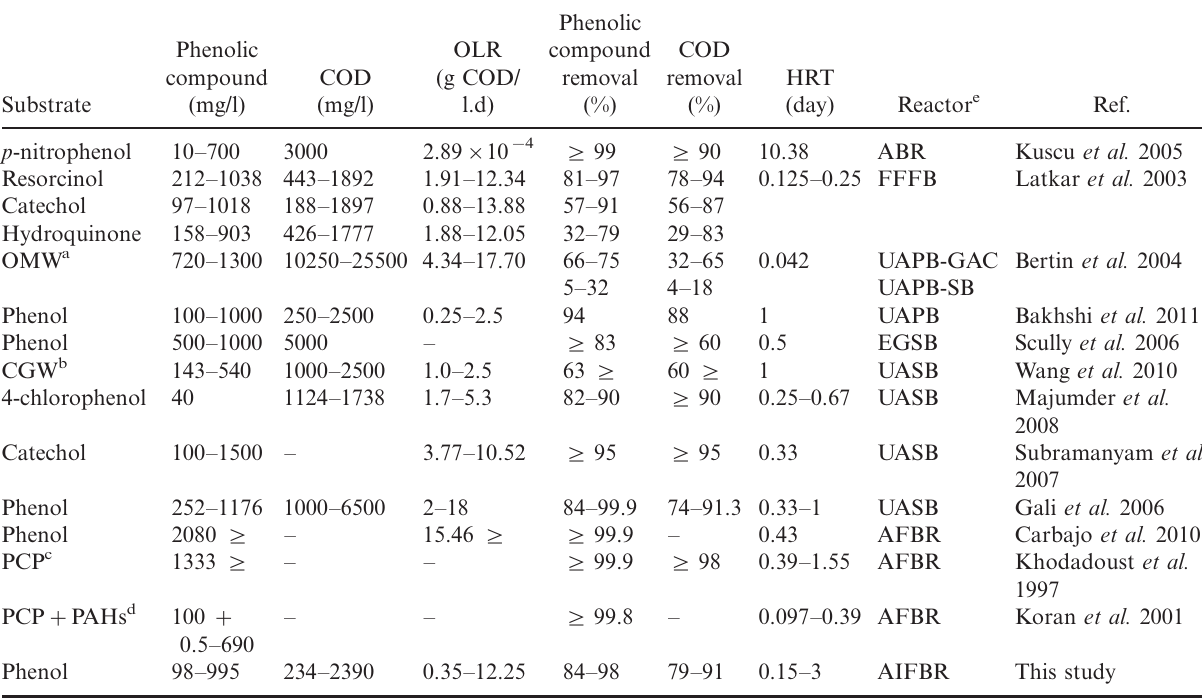
Table 2. Studies of anaerobic biodegradation of phenolic compounds